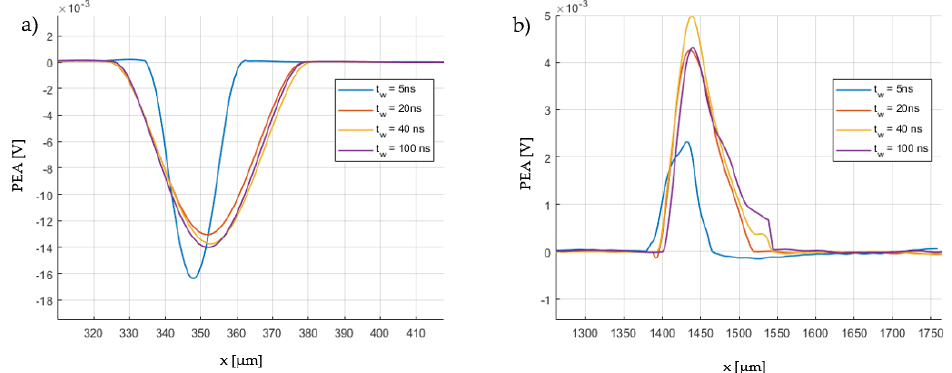
Figure 4. Space charge profile in LDPE d = 1 mm sample measured for different pulser widths t w , sensor d s = 9 µm, HVDC U = 10 kV, signal after deconvolution—comparison between signals (Figure 3) from ( a ) GND and ( b ) HV electrodes.